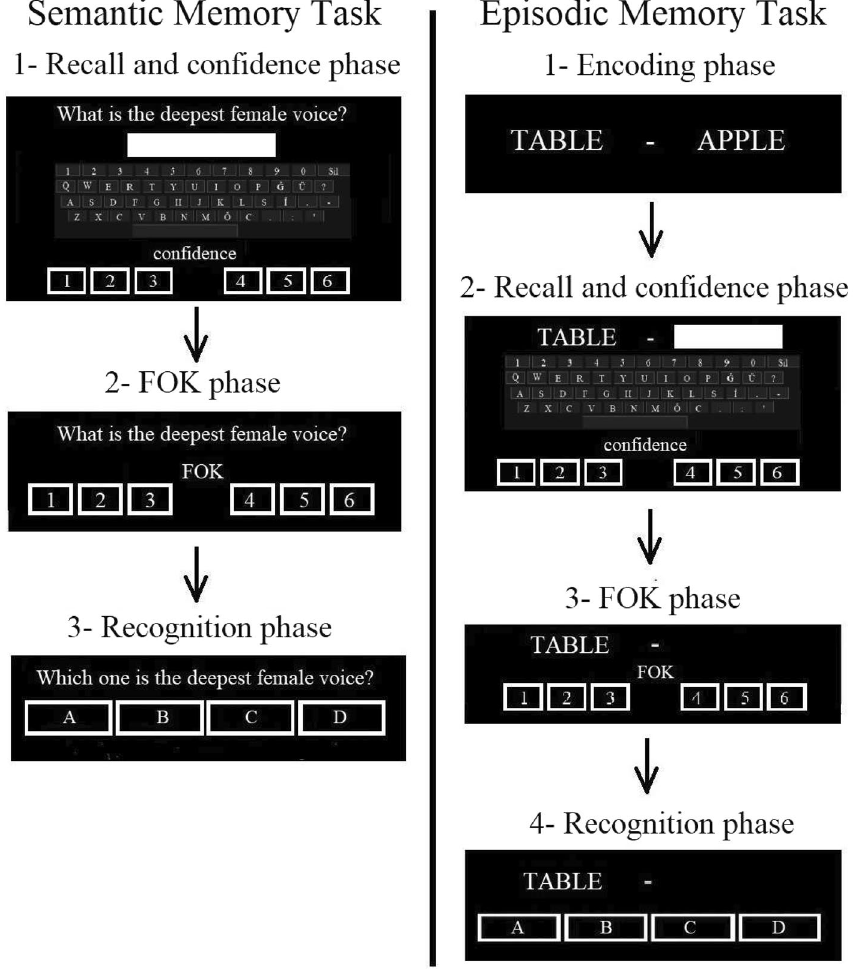
Figure 6. Semantic and episodic memory tasks were used in the